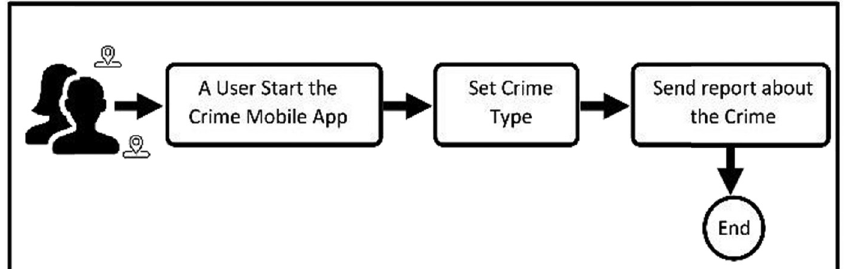
Figure 3: Incident reporting steps by unknown